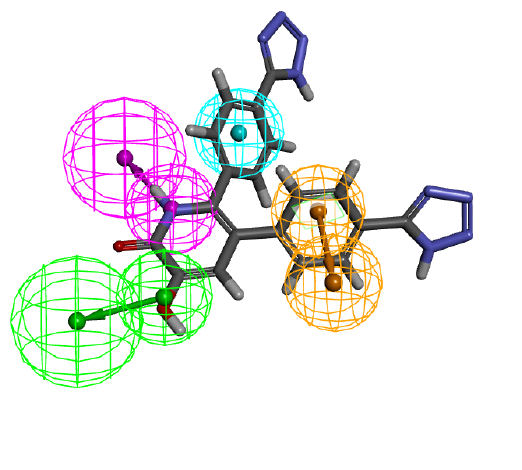
Figure 5. Pharmacophore mapping of the most active, less active compounds in the test set. ( A ) Hypo1 mapped on to the most active compound T32 ; ( B ) Hypo1 mapped on to the least active compound T29 . The employed three validation strategies exhibited that the Hypo1 model could be chosen as a significant pharmacophore model for further screening chemical databases with diverse structural entities.